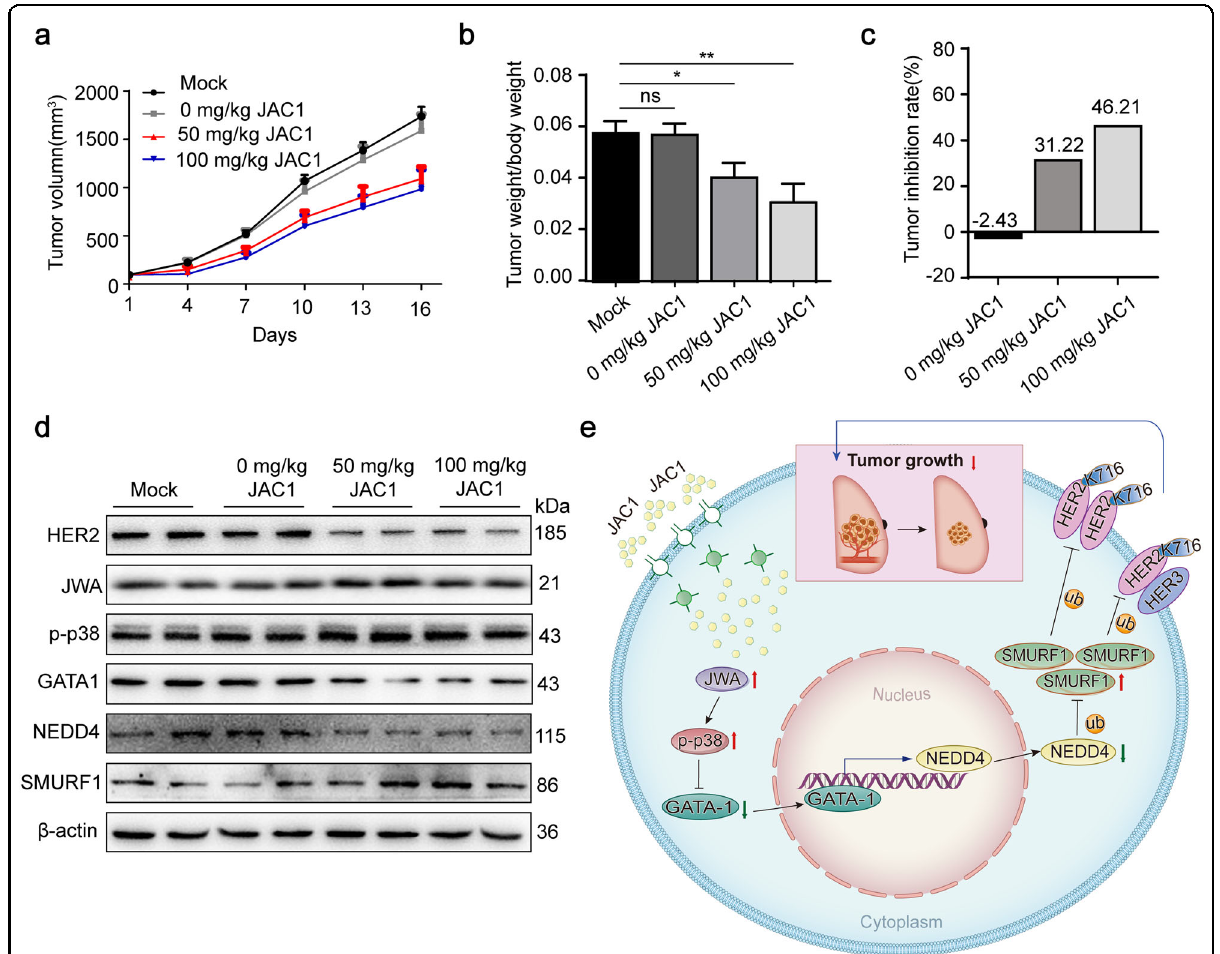
Fig. 6 JAC1 modulates HER2 ubiquitination and inhibits tumor growth in vivo. a The curve of tumor growth of BT474 xenografted breast cancer after JAC1 treatment. b , c The ratio of tumor weight/body weight in each group ( b ), tumor inhibition rate by JAC1 ( c ). d The expressions of cell proliferation biomarkers and mechanism biomarkers in isolated representative tumor tissues of each group; all the biomarkers were determined by western blot. e A schematic overview of how JAC1 degrades HER2 in breast cancer cells. * P < 0.05; ** P < 0.01; *** P < 0.001. N.S. no signi fi cant